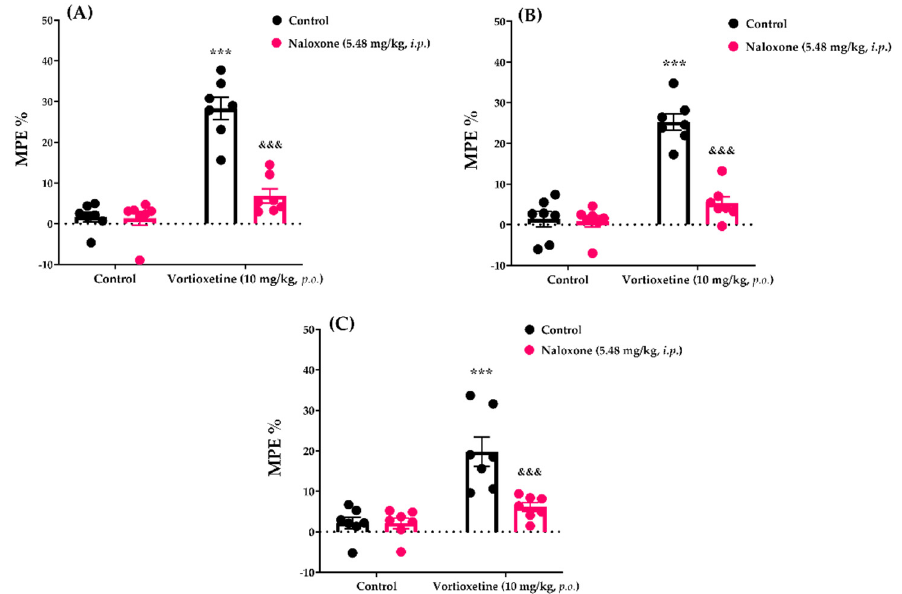
Figure 10. The effects of naloxone pretreatments on vortioxetine-induced analgesia in the tail-clip ( A ), tail-immersion ( B ) and hot-plate ( C ) tests. Significant difference against vehicle treated control groups *** p < 0.001; Significant difference against vortioxetine administrated control groups &&& p < 0.001. Two-way ANOVA, post-hoc Bonferroni test, n = 7.